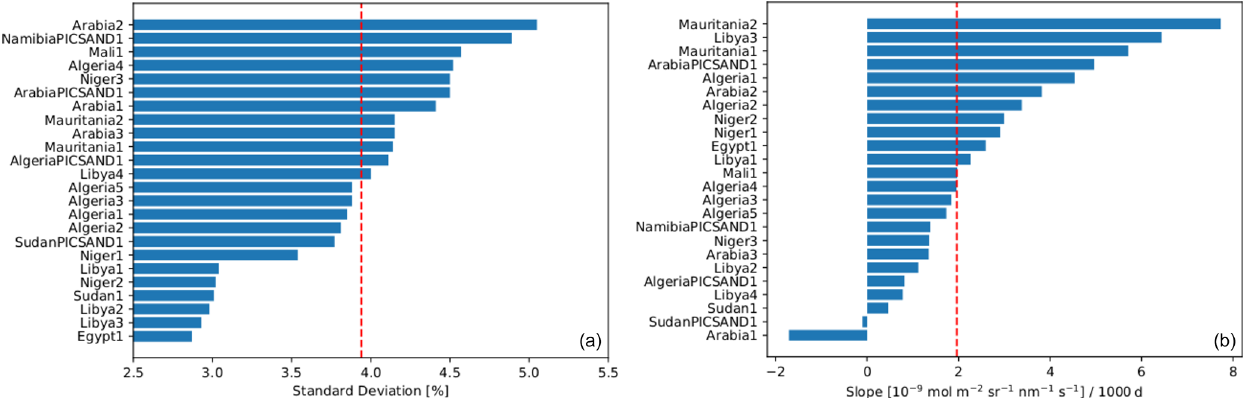
Figure 4. Sorted bar diagrams for the standard deviation of the radiance distribution of each site (a) and the slope of a linear fit, expressed in the slope per 1000d (b) . In red we show the median standard deviation and median slope for the distribution.